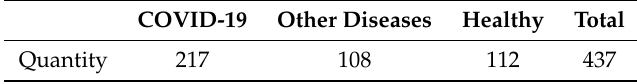
Table 5. Overview of the image dataset used in this